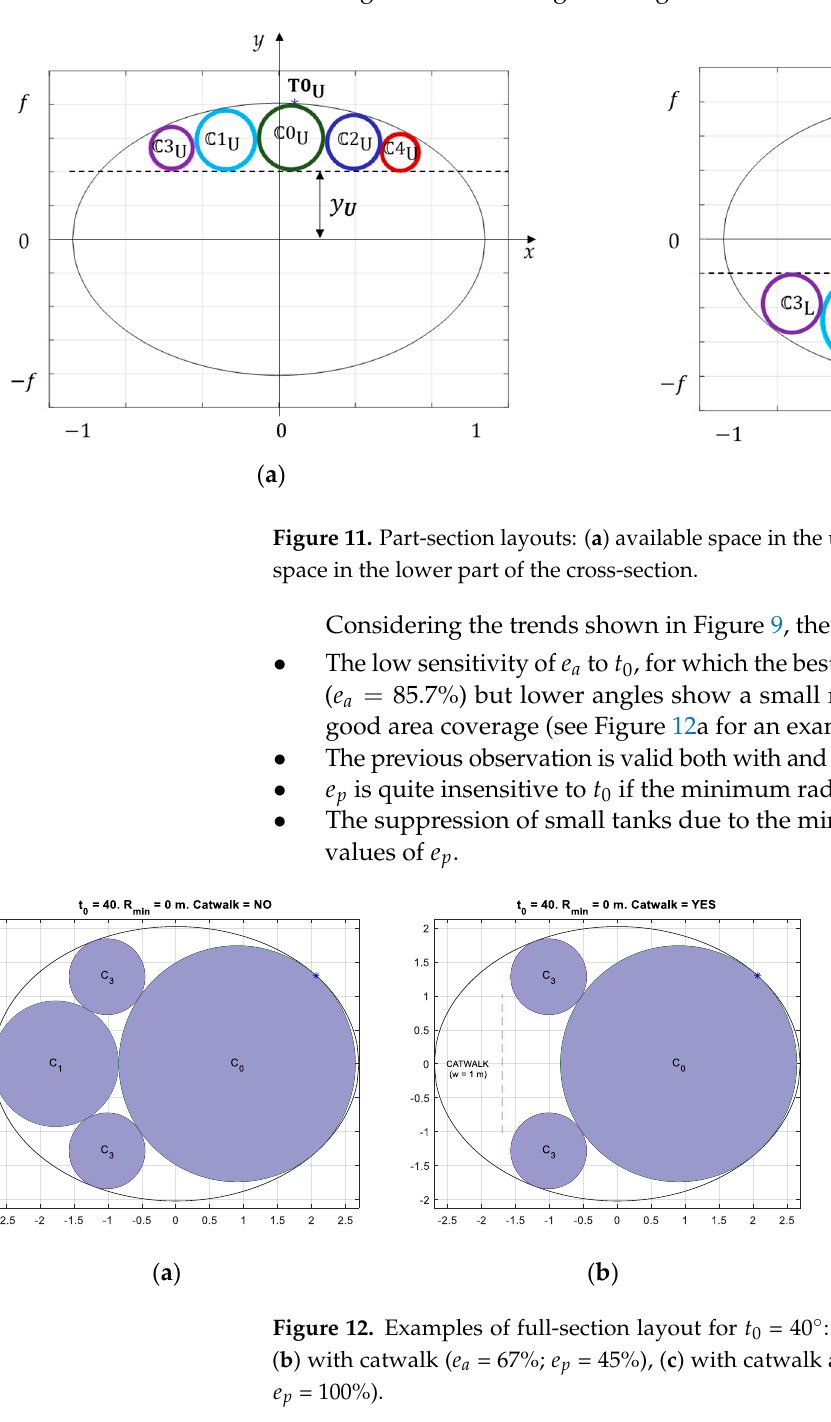
Figure 10. Examples of full-section layouts without minimum radius constraints for three different 𝑡 (cid:2868) values: ( a ) 0°, ( b ) 70°, ( c ) 90°. Whereas in Figure 9a each configuration with 𝑡 (cid:2868) (cid:3405) 0 is composed of 7 tanks (see